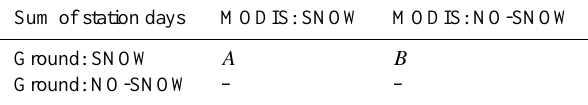
Table 2. Confusion matrix defining the snow mapping accuracy (SI) by relating the ground-based snow depth observations (Ground) and the satellite snow cover from MODIS. A and B represent the num- ber of cloud-free station days in a particular classification